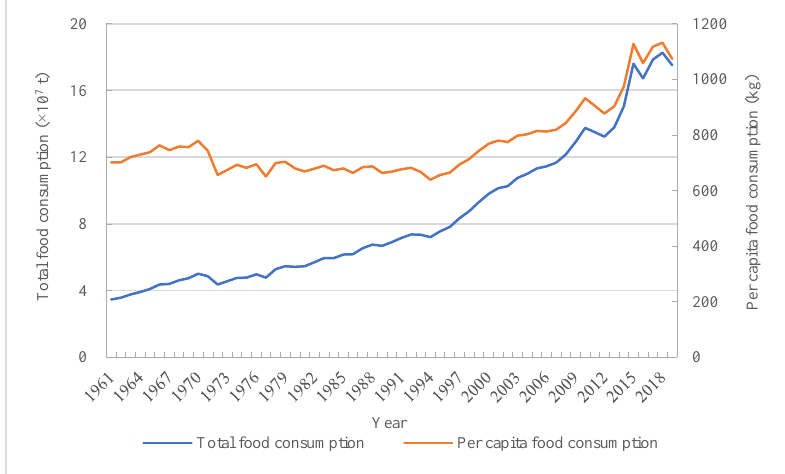
Figure 1. Changes of total and per capita food consumption in Bangladesh.